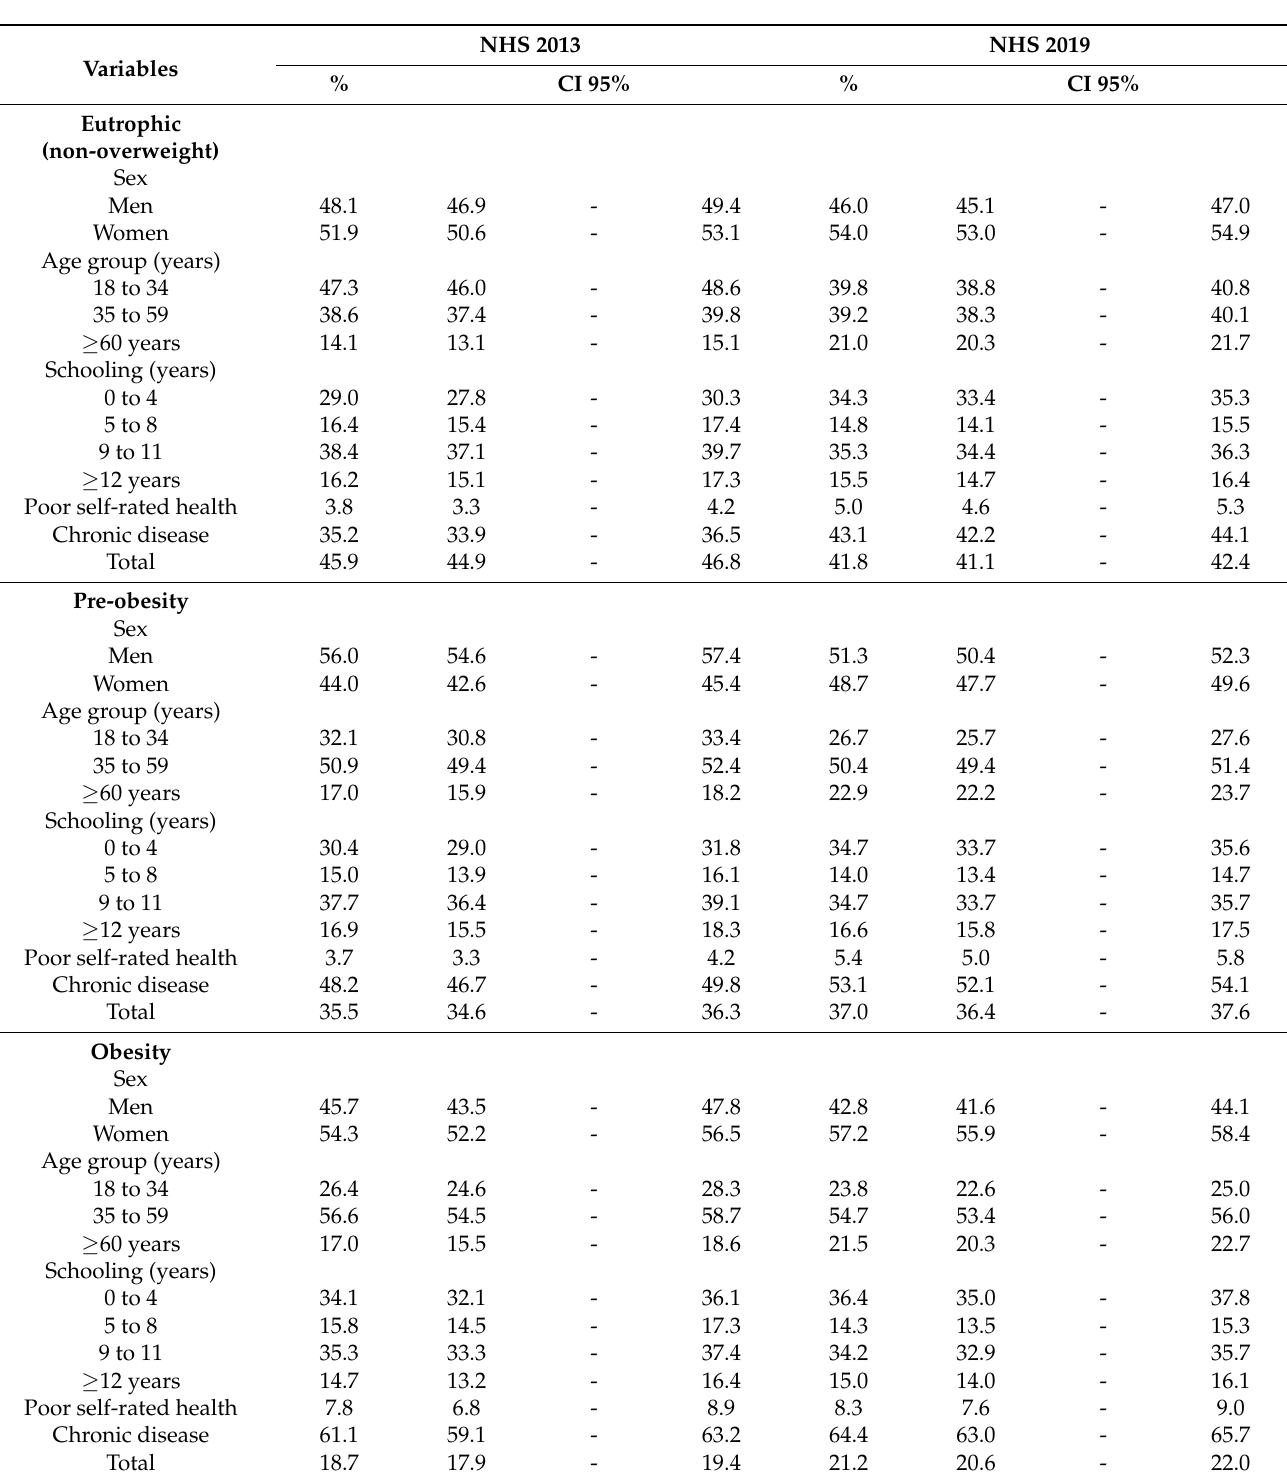
Table 1. Distribution (%) of the Brazilian adult, according to nutritional status and sociodemographic characteristics and health conditions. National Health Survey (NHS), 2013 ( n = 40,942) and NHS, 2019 ( n =